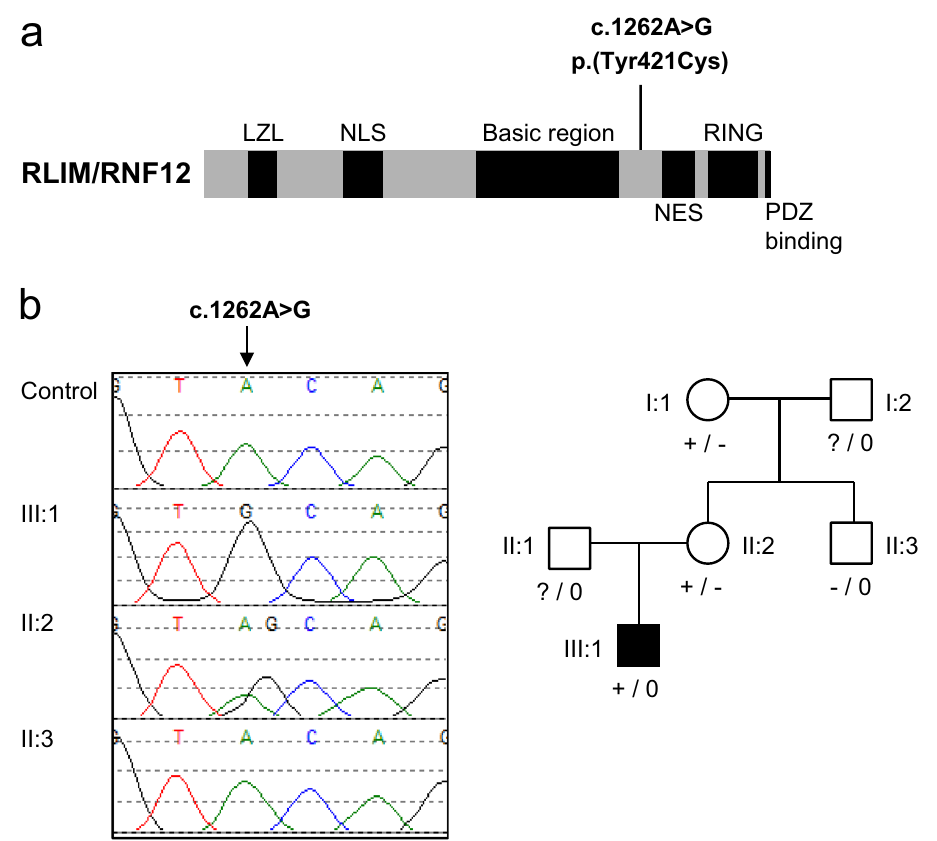
Figure 1. Identification of RLIM p.(Tyr421Cys), a novel variant in a severe form of Tonne–Kalscheuer Syndrome. ( a ) Schematic diagram of the RLIM protein domain structure, with the position of the c.1262A>G p.(Tyr421Cys) variant identified by exome sequencing indicated. ( b ) (Left panel) Genomic DNA sequencing electropherogram identifying the RLIM c.1262A>G p.(Tyr421Cys) variant within the kindred. Figure was generated using SoftGenetics Mutation Surveyor v5.01 (https:// softg eneti cs. com/ mutat ionSu rveyor. php). (Right panel) Family pedigree showing inheritance of the RLIM c.1262A>G p.(Tyr421Cys)